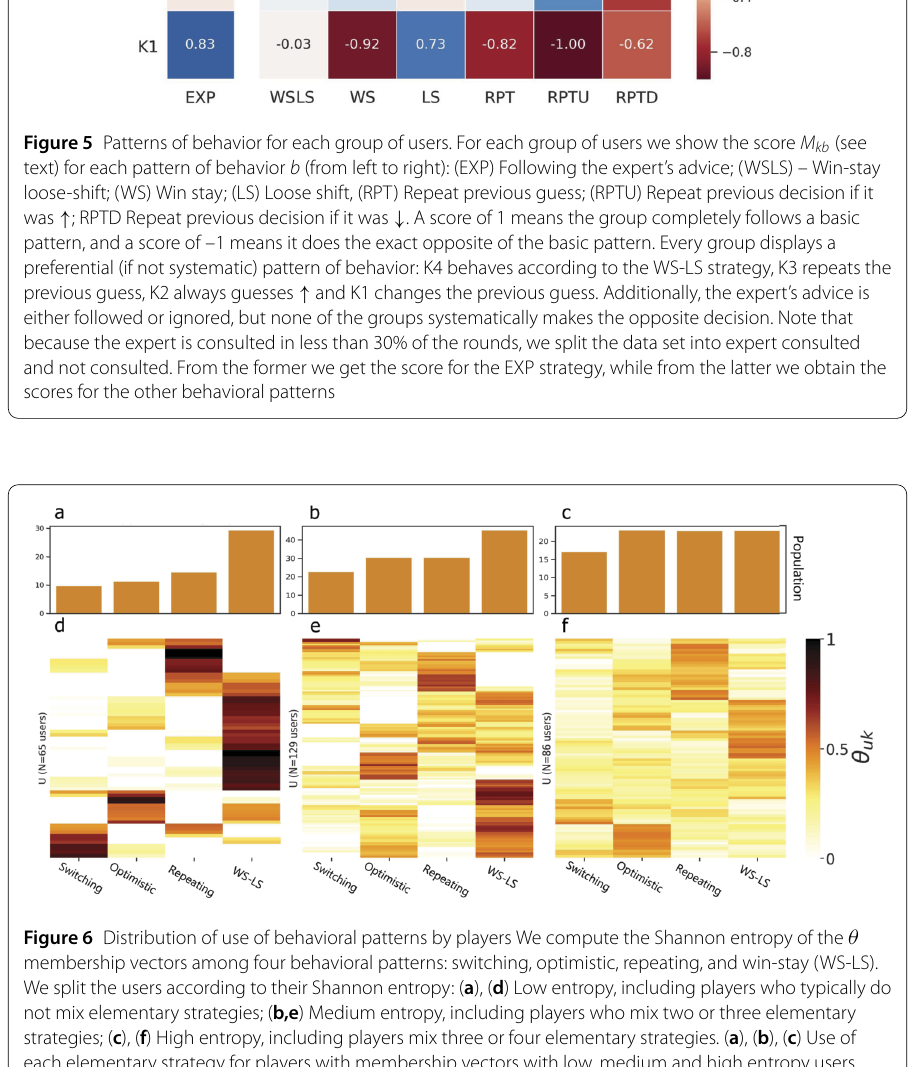
trend for both players using a single elementary strategy (low entropy in Fig. 6) and those combining various elementary strategies (high entropy). This finding is consistent with the conclusions of numerous studies assessing the wide use of this behavior in various natu- ral systems such as children education [32, 33], evolutionary systems [34, 35], or games involving adversity